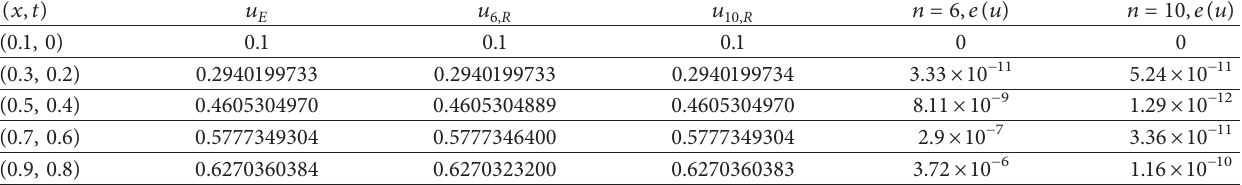
Table 5: Numerical result of Example 4.